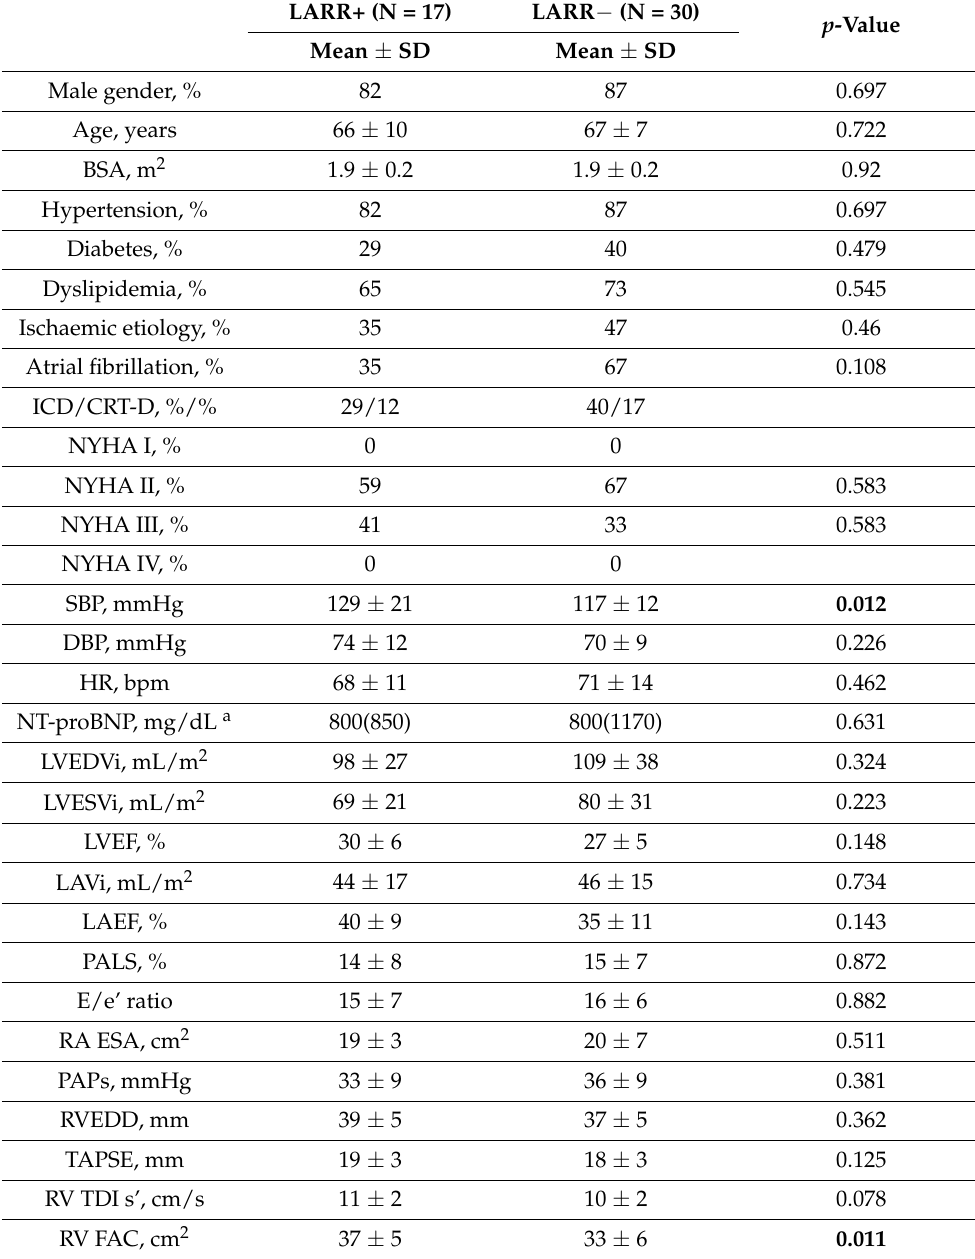
Table 4. Clinical and echocardiographic parameters in LARR+ and LARR −